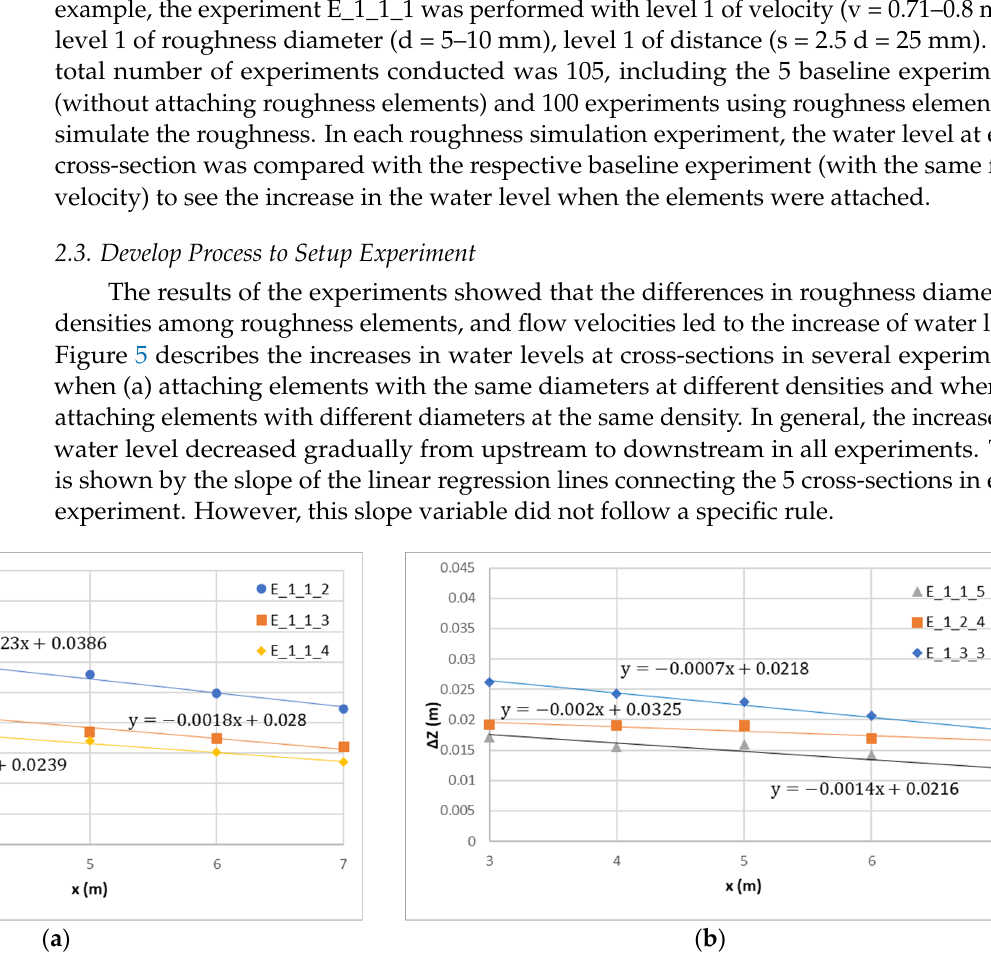
Figure 5. The increase of water level at the cross-sections in experiments with: ( a ) same diameters & different densities; ( b ) different diameters & same densities.